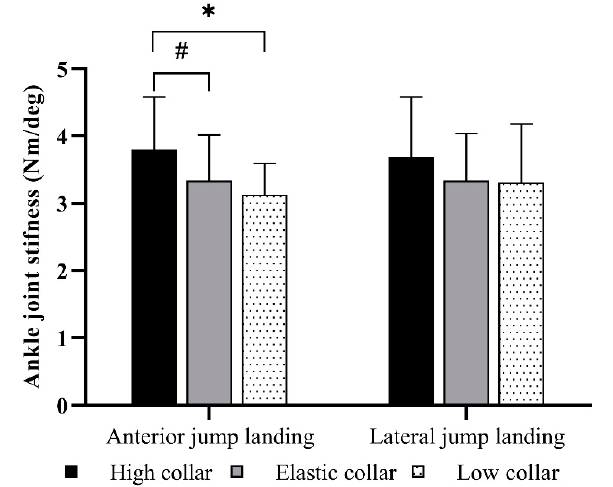
Figure 4. Ankle joint stiffness for both anterior and lateral jump landings in three shoe conditions: high collar, elastic collar, and low collar. * indicates a significant pairwise difference between the high collar and low collar; # indicates a significant pairwise difference between the high collar and elastic collar.